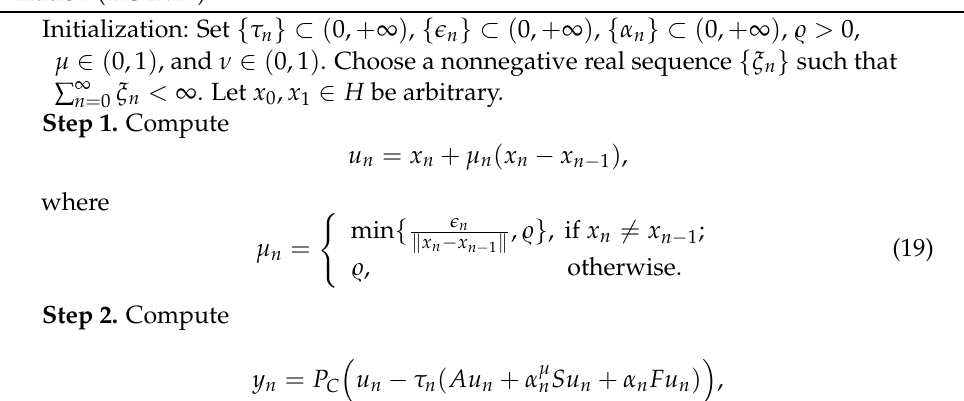
Algorithm 4: Modified inertial subgradient extragradient method with regular- ization